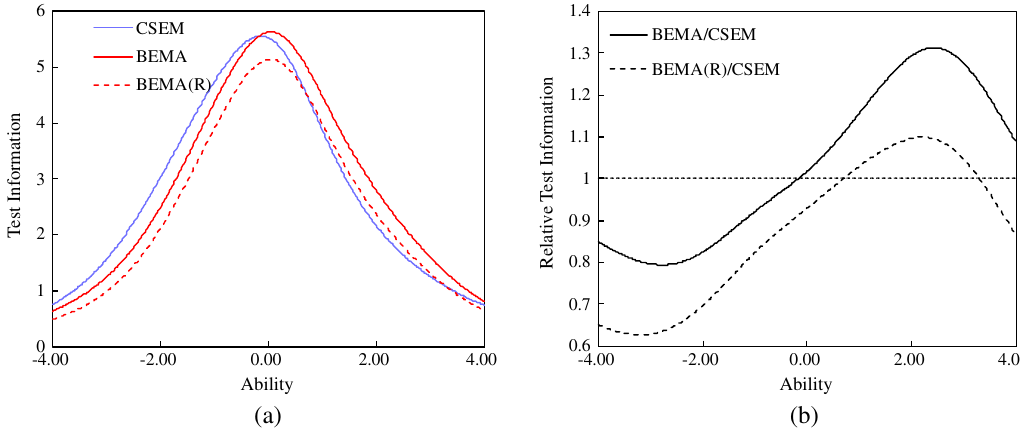
FIG. 7. Test information curves (a) and relative test information curves (b). The relative test information can be obtained by dividing the test information of the BEMA by that of the CSEM at a given ability